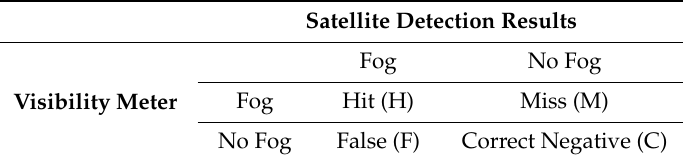
Table 4. Contingency table for fog detection